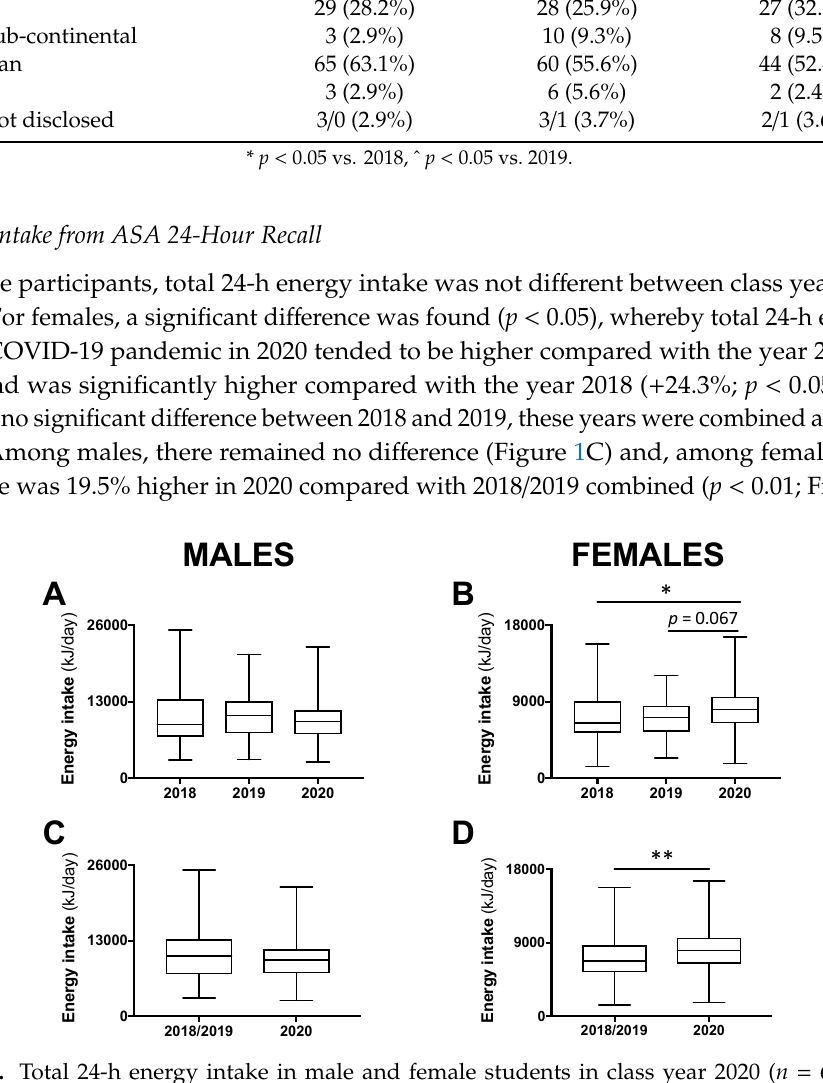
Figure 1. Total 24-h energy intake in male and female students in class year 2020 ( n = 64